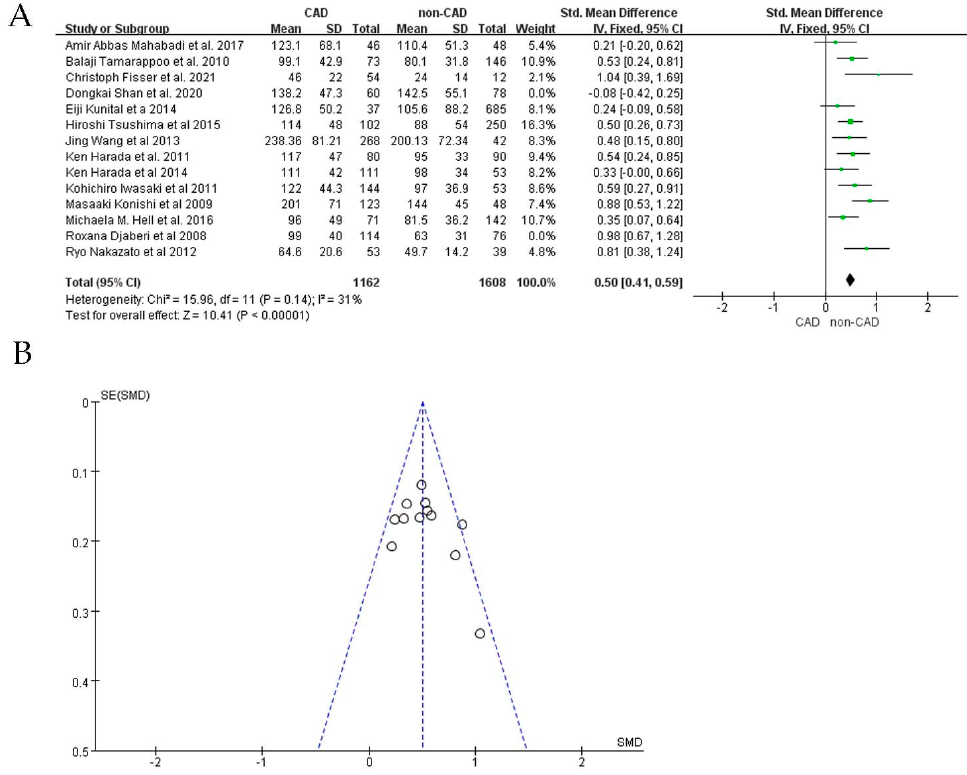
Figure 4. SMD of EAT volume between CAD patients and non − CAD patients after sensitivity analysis. ( A ): Forest plot; ( B ) funnel plot.